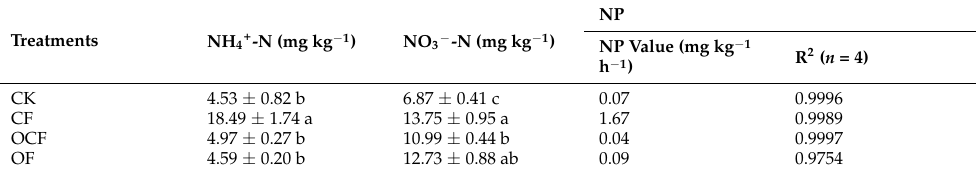
Table 4. Concentration of NH 4+ -N and NO 3 − -N (0–20 cm) in tobacco growing field under different